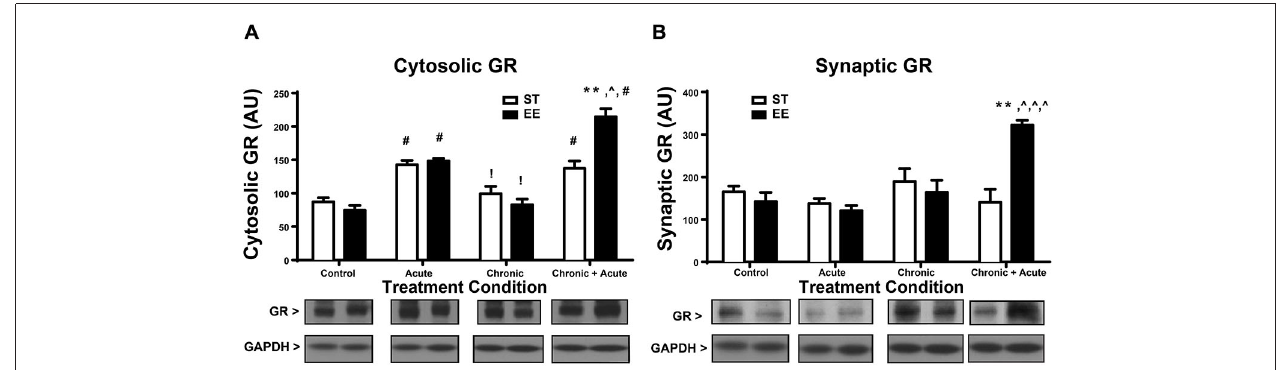
FIGURE 2 | Environmental enrichment increases glucocorticoid receptor (GR) levels after chronic + acute stress. (A) Cytosolic GR increased significantly for both ST- and EE-housed animals after acute stress compared to controls of the same housing condition ( # p < 0.01). Both ST- and EE-housed animals showed a significant decrease in cytosolic GR levels after chronic stress compared to acute stress treatment of the same housing condition (! p < 0.01). Chronic + acute stress in EE-housed animals showed a significant increase in cytosolic GR compared to ST-housed animals for the same treatment ( ∗∗ p < 0.01) and compared to chronic stress for EE housed animals ( ∧ p < 0.01). Chronic + acute stress for both ST- and EE-housed animals significantly increased cytosolic GR compared to controls in the same housing conditions ( # p < 0.01). (B) Synaptic GR significantly increased after chronic + acute stress for EE housed animals compared to all other treatments within the same housing condition ( ∧ p < 0.01) and compared to ST chronic + acute ( ∗∗ p < 0.01).